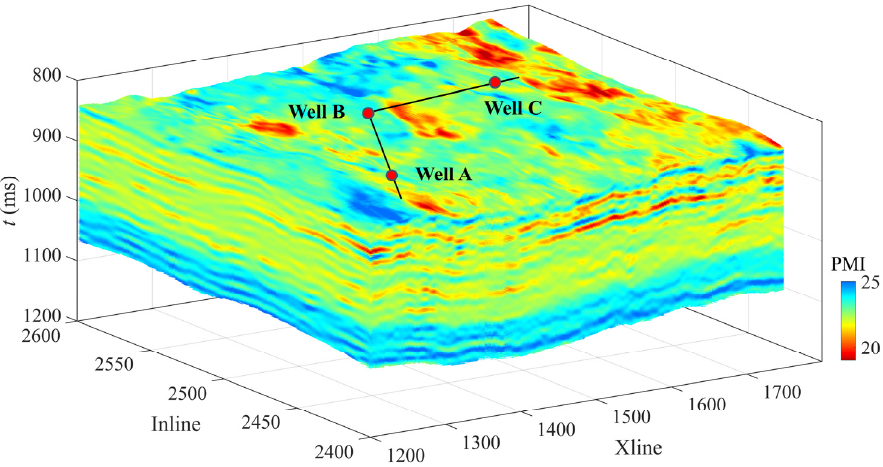
Figure 17. Seismic-inverted 3D cube of I P in the tight sandstone formations in the study area.